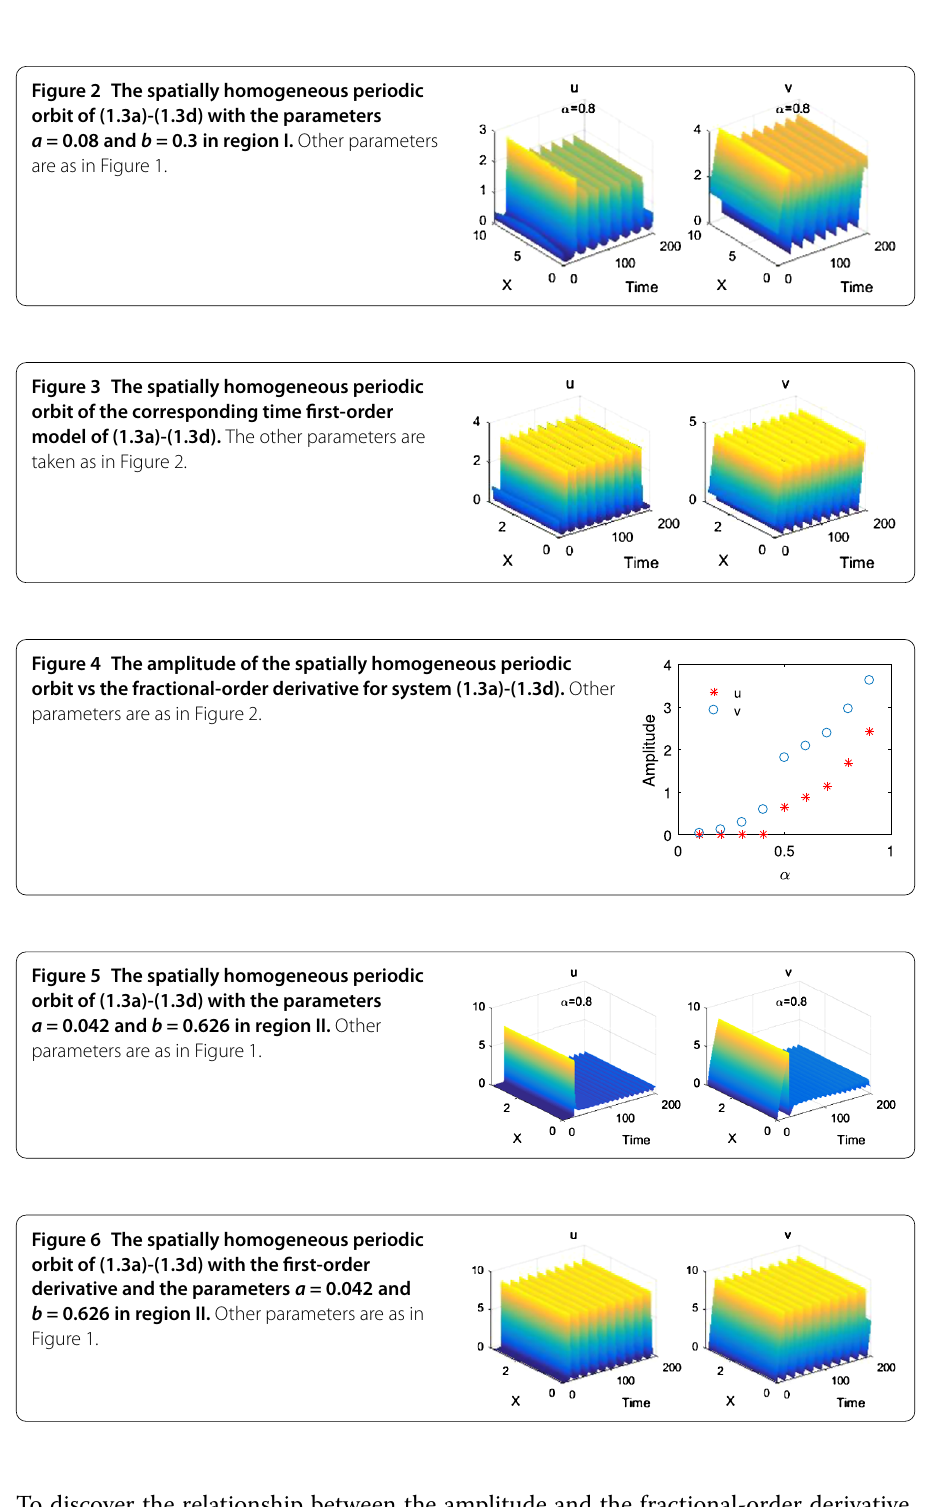
To discover the relationship between the amplitude and the fractional-order derivative, we plot Figure . In this figure, the amplitudes of the periodic orbits of u and v increase with the fractional order α . We take a = . and b = . in region II in Figure  and respectively plot the spatially homogeneous periodic orbits of system (.a)-(.d) and its corresponding first-order system, see Figures  and . The amplitude of the spatially homogeneous periodic orbits of system (.a)-(.d) are still smaller in comparison